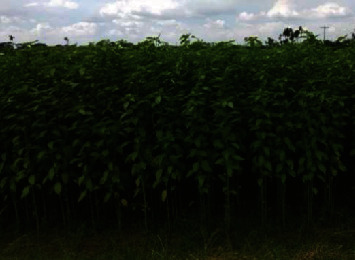
Growing of experimental tossa jute plants.